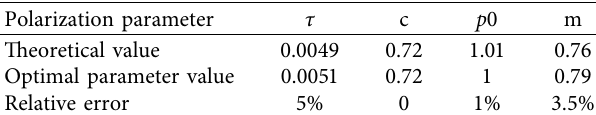
Table 2: Single parameter solution